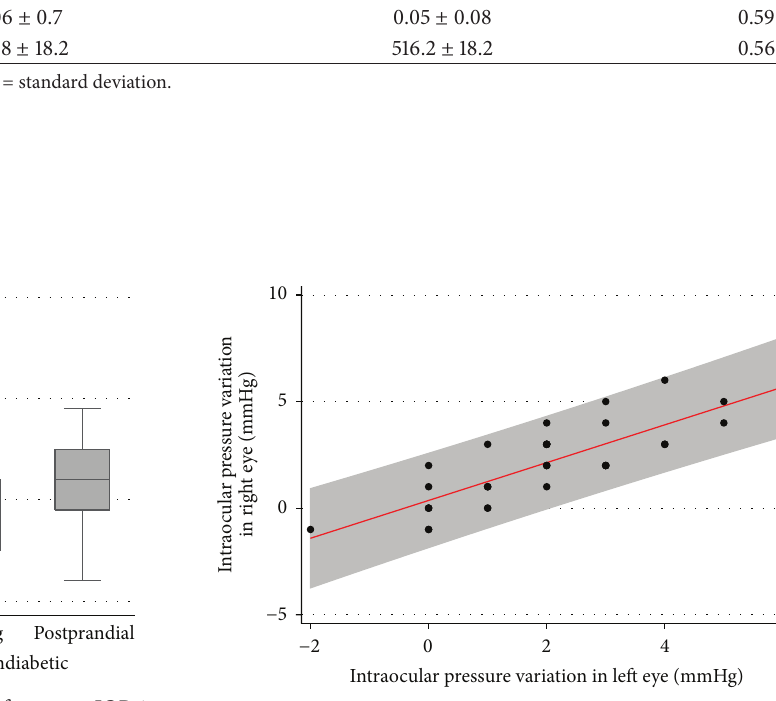
Figure 1: Box plots showing the distribution of average IOP in diabetic and nondiabetic groups in the two different times of meas- urements. Box represents median and interquartile range. Whiskers correspond to maximum and minimum 1.5IQR.